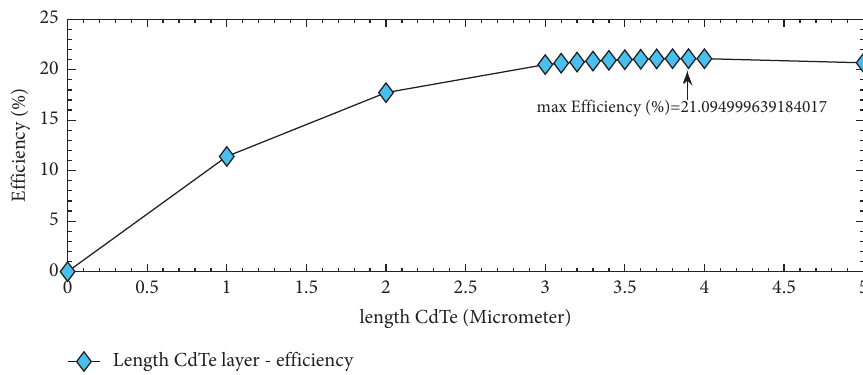
Figure 8: Performance diagram in terms of CdTe layer